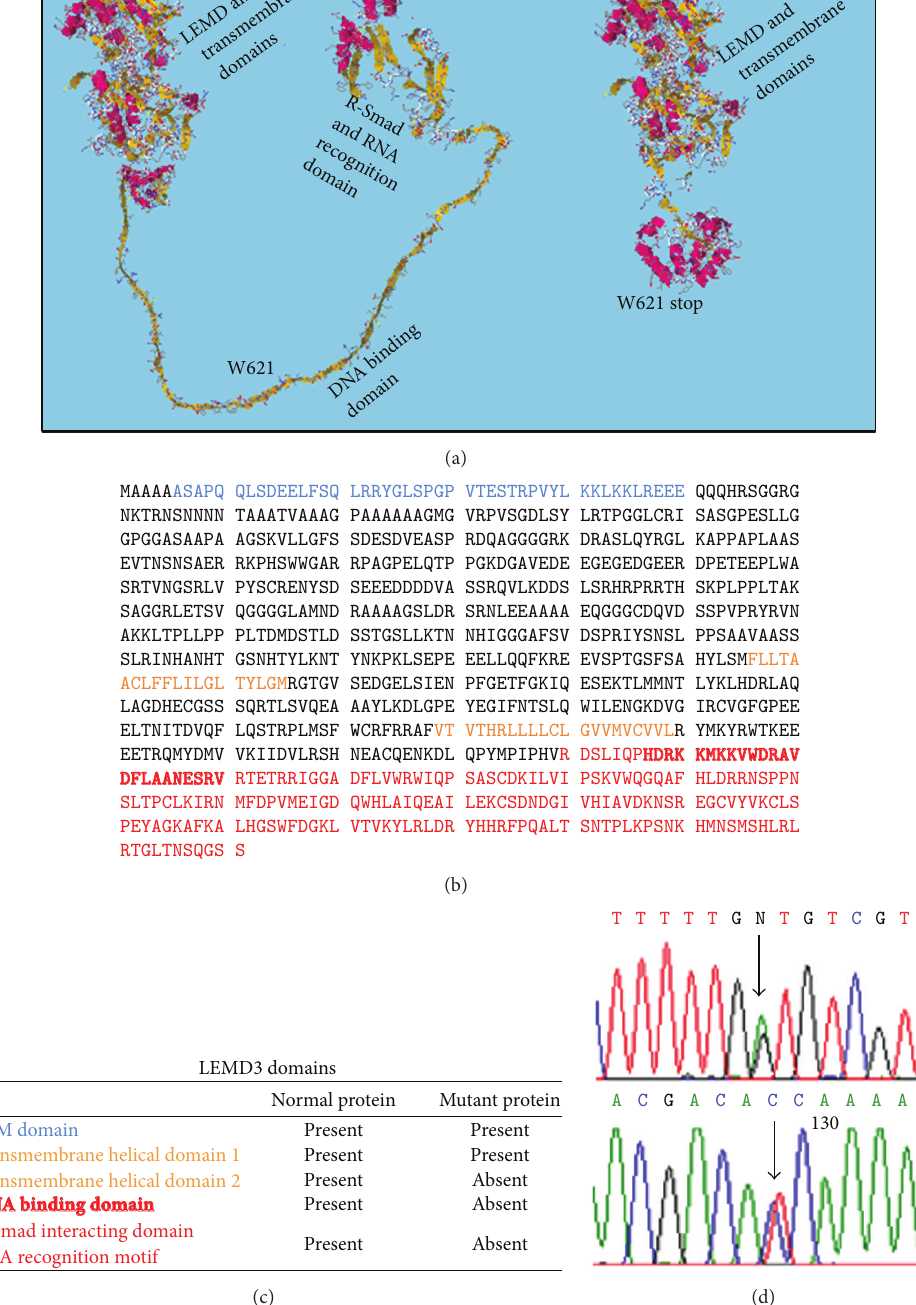
Figure 4: Characterization of novel LEMD3 mutation. (a) 3D predicted conformation of native and mutated p.Trp620X Man1 protein (EsyPred3d modeling software) [31]. Note deletion of the DNA-binding and R-Smad recognition domains. (b) Amino acid sequence of Man1; letters represent amino acids as defined by IUPAC. The Trp620X codon is indicated. (c) List of functional domains and presence of domains in normal and mutated Man1 protein. (d) DNA sequence of LEMD3 , highlighting the novel c.1863G > A